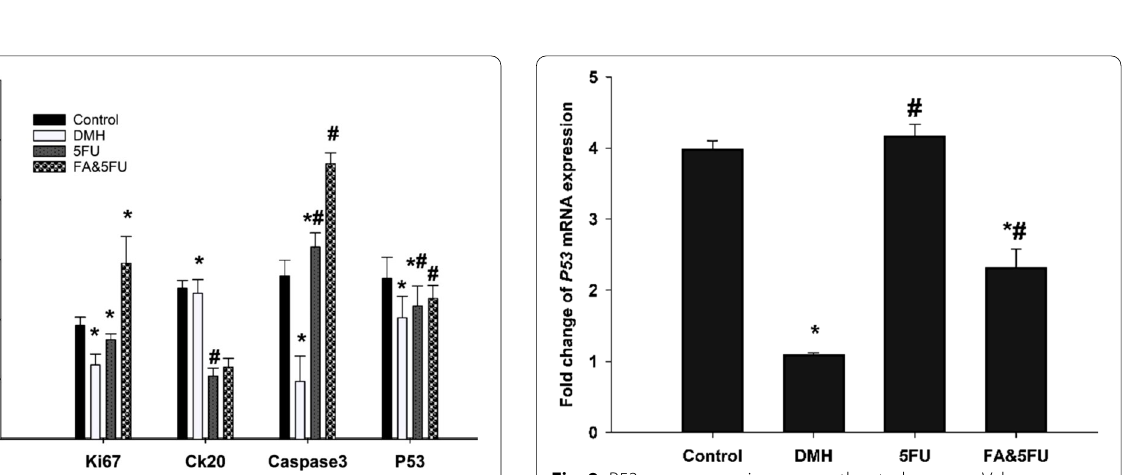
Fig. 7 Photomicrographs of colon sections of different groups immune-stained with P53 ( Caspase-3 IHC positivity. B : DMH group showed weak p53 immunoreactivity. C : 5FU group showing severe nuclear P53 expression. D : FA-5FU group showed severe P53 expression